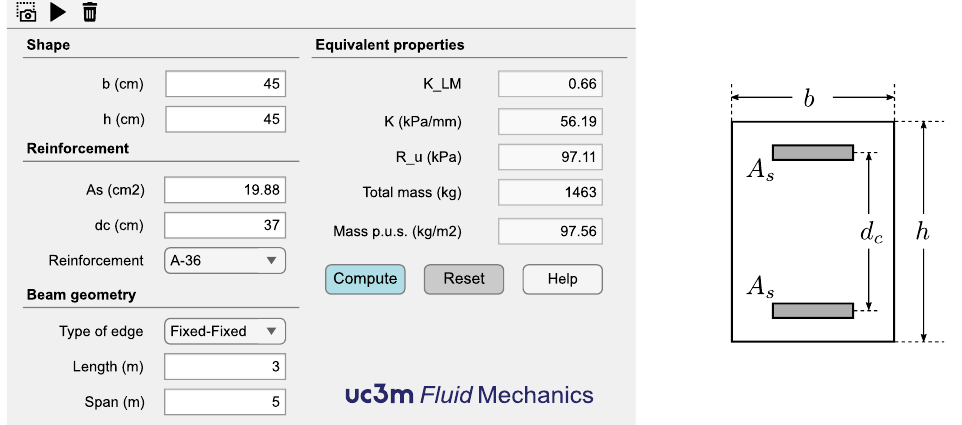
Figure 12. Reinforced concrete beam calculation assistant showing results for a pillar of 45 × 45 cm 2 with a length of 3 m and a spacing between pillars of 5 m. The pillar is reinforced using 5 A36 steel reinforcement bars of 22.5 mm of diameter per side spaced apart 37